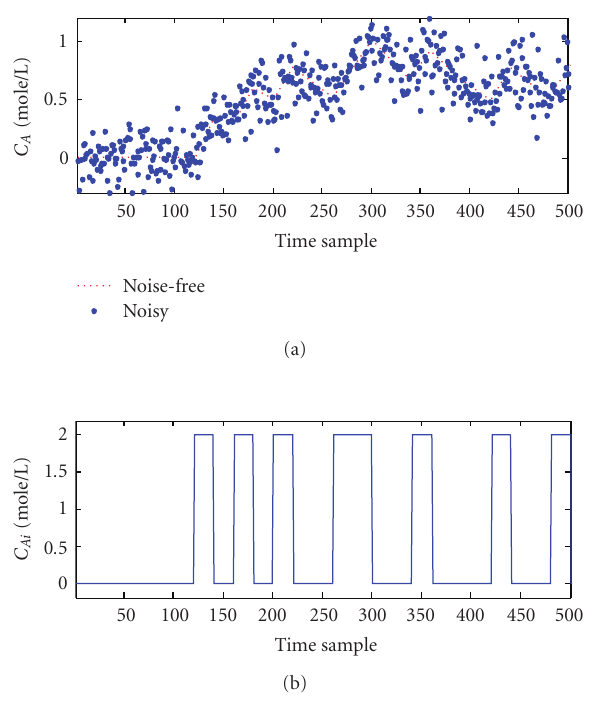
Figure 4: A 500-sample input-output data set.